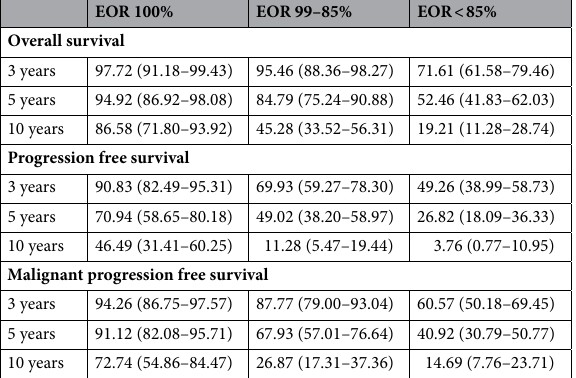
Table 5. Overall survival, progression free survival and malignant progression free survival at 3, 5 and 10 years after surgery according to extent of resection. Table showing overall survival, progression free survival and malignant progression free survival at 3, 5 and 10 years after surgery according to extent of resection. Results are displayed as percentage (95% confidence interval). EOR = extent of resection.